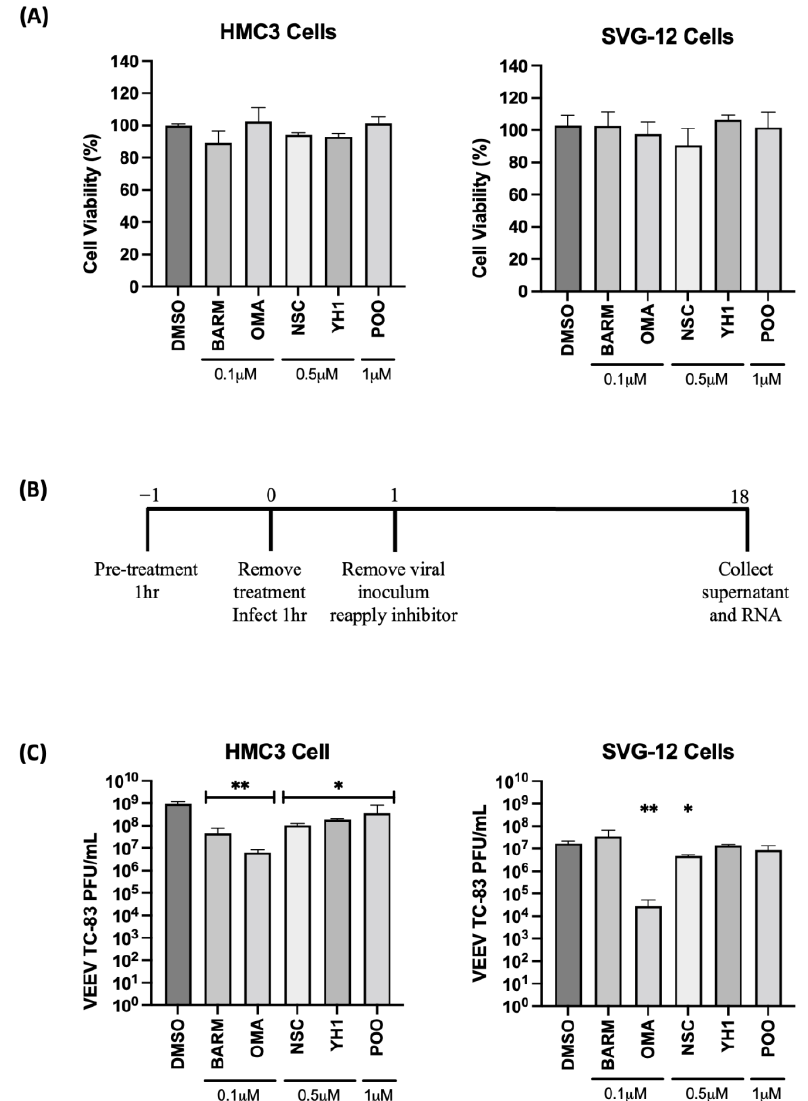
Figure 2. Inhibitors of UPS-mediated signaling inhibit VEEV-TC83 in infected microglial (HMC3) and astroglial (SVG-p12) cells. ( A ) HMC3 and SVG-p12 cells were plated in 96-well format plates and treated with inhibitors at the indicated concentrations. DMSO-treated cells were maintained as vehicle-alone controls. Treated cells were maintained at 37 °C, 5% CO 2 for 24 h, and cell viability was quantified by Cell Titer Glo assay. ( B ) Schematic of infection. ( C ) HMC3 and SVG-p12 cells were pre-treated for 1 h with inhibitors or DMSO, followed by an infection with VEEV-TC83 for 1 h. Inhibitor-containing medium was added back to the cells after removal of the viral overlay and cells were incubated at 37 °C, 5% CO 2 . Eighteen hours post-infection, supernatants were collected and assessed by plaque assay for viral load. Infectious virus titers are reported as plaque-forming units (PFU)/mL. Statistical analysis was performed using One-way ANOVA with Dunnett’s post-test. * p < 0.05, ** p <